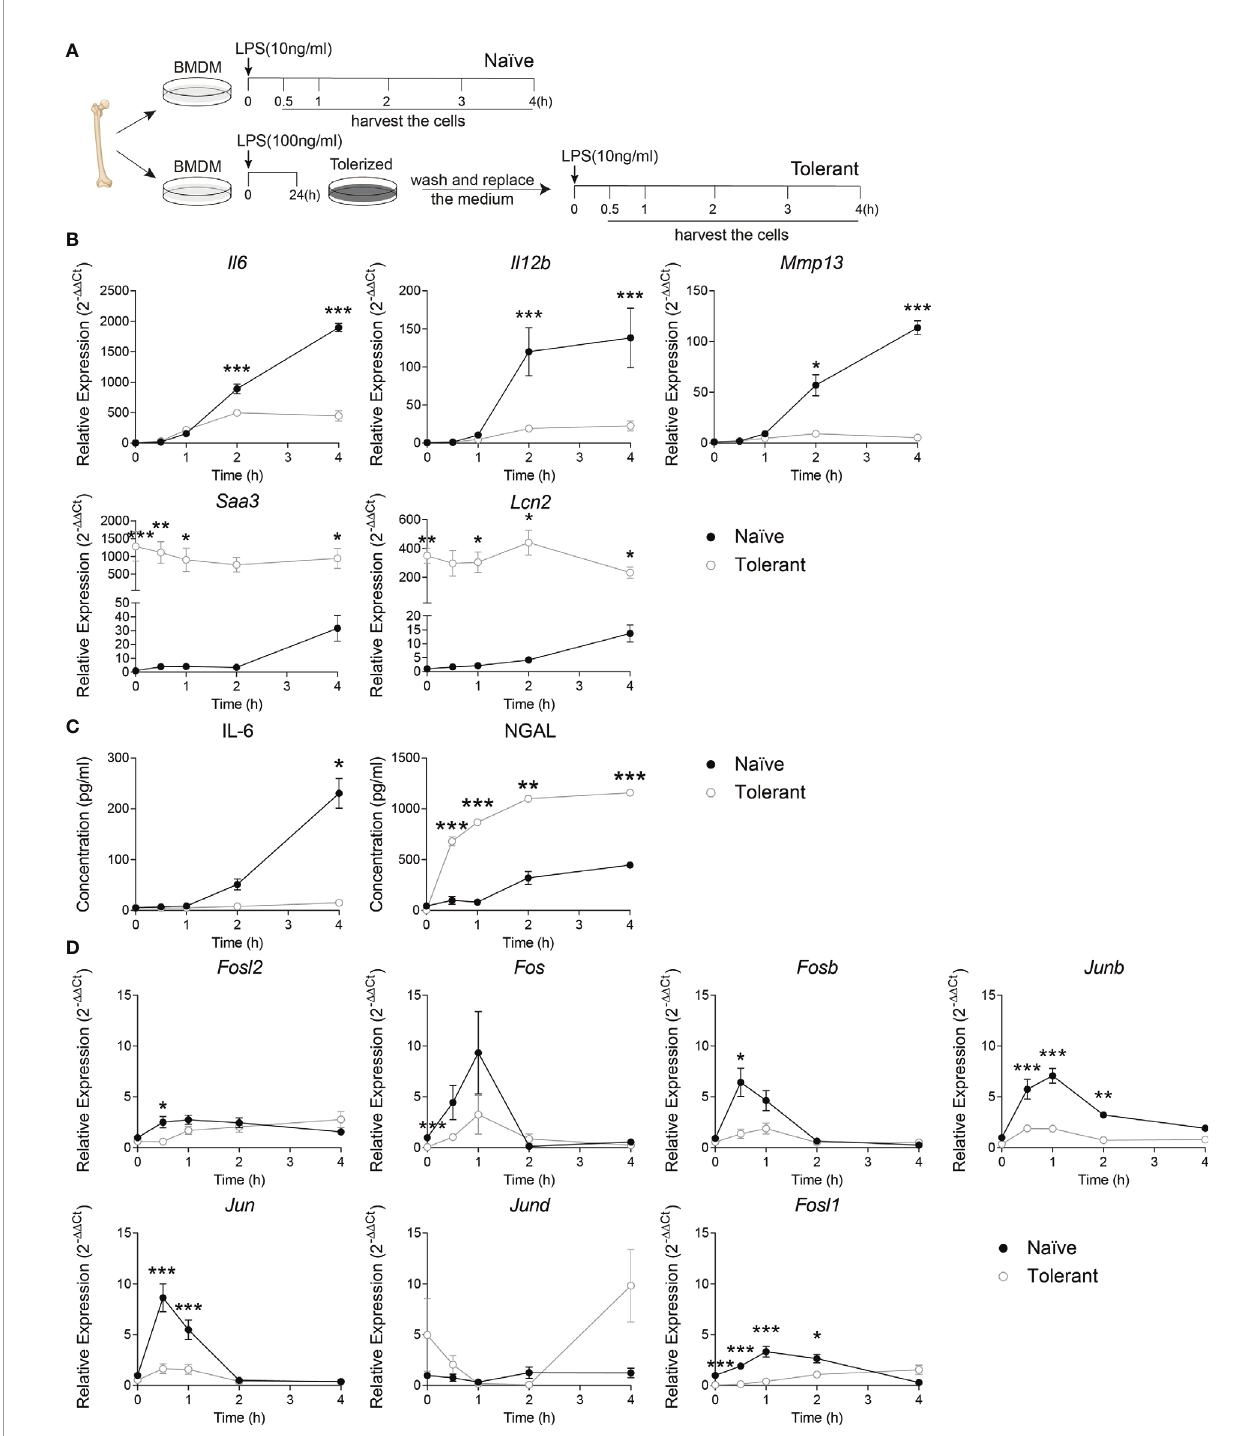
FIGURE 1 | Fosl1 expression is altered after induction of endotoxin tolerance in murine macrophages. (A) Experimental scheme of the induction of endotoxin tolerance in wild type murine BMDM. A kinetic analysis of genes and proteins expression was performed at the indicated time point in macrophages harvested following one (Naïve) or two (Tolerant) LPS stimulations. (B) Quantitative RT-PCR analysis of the expression of tolerizable genes ( Il6, Il12b Mmp13 ) and non-tolerizable genes ( Saa3, Lcn2 ), normalized to the expression of Actb . (C) Quanti fi cation of IL-6 and NGAL protein secretion in cell culture supernatant. (D) Quantitative RT-PCR analysis of AP-1 transcription factor genes, normalized to the expression of Actb . Data are shown as mean ± s.e.m. *p < 0.05; **p < 0.01; ***p < 0.001 by two-way RM ANOVA with Tukey ’ s multiple comparisons test. The data shown are from one experiment representative of three independent biological